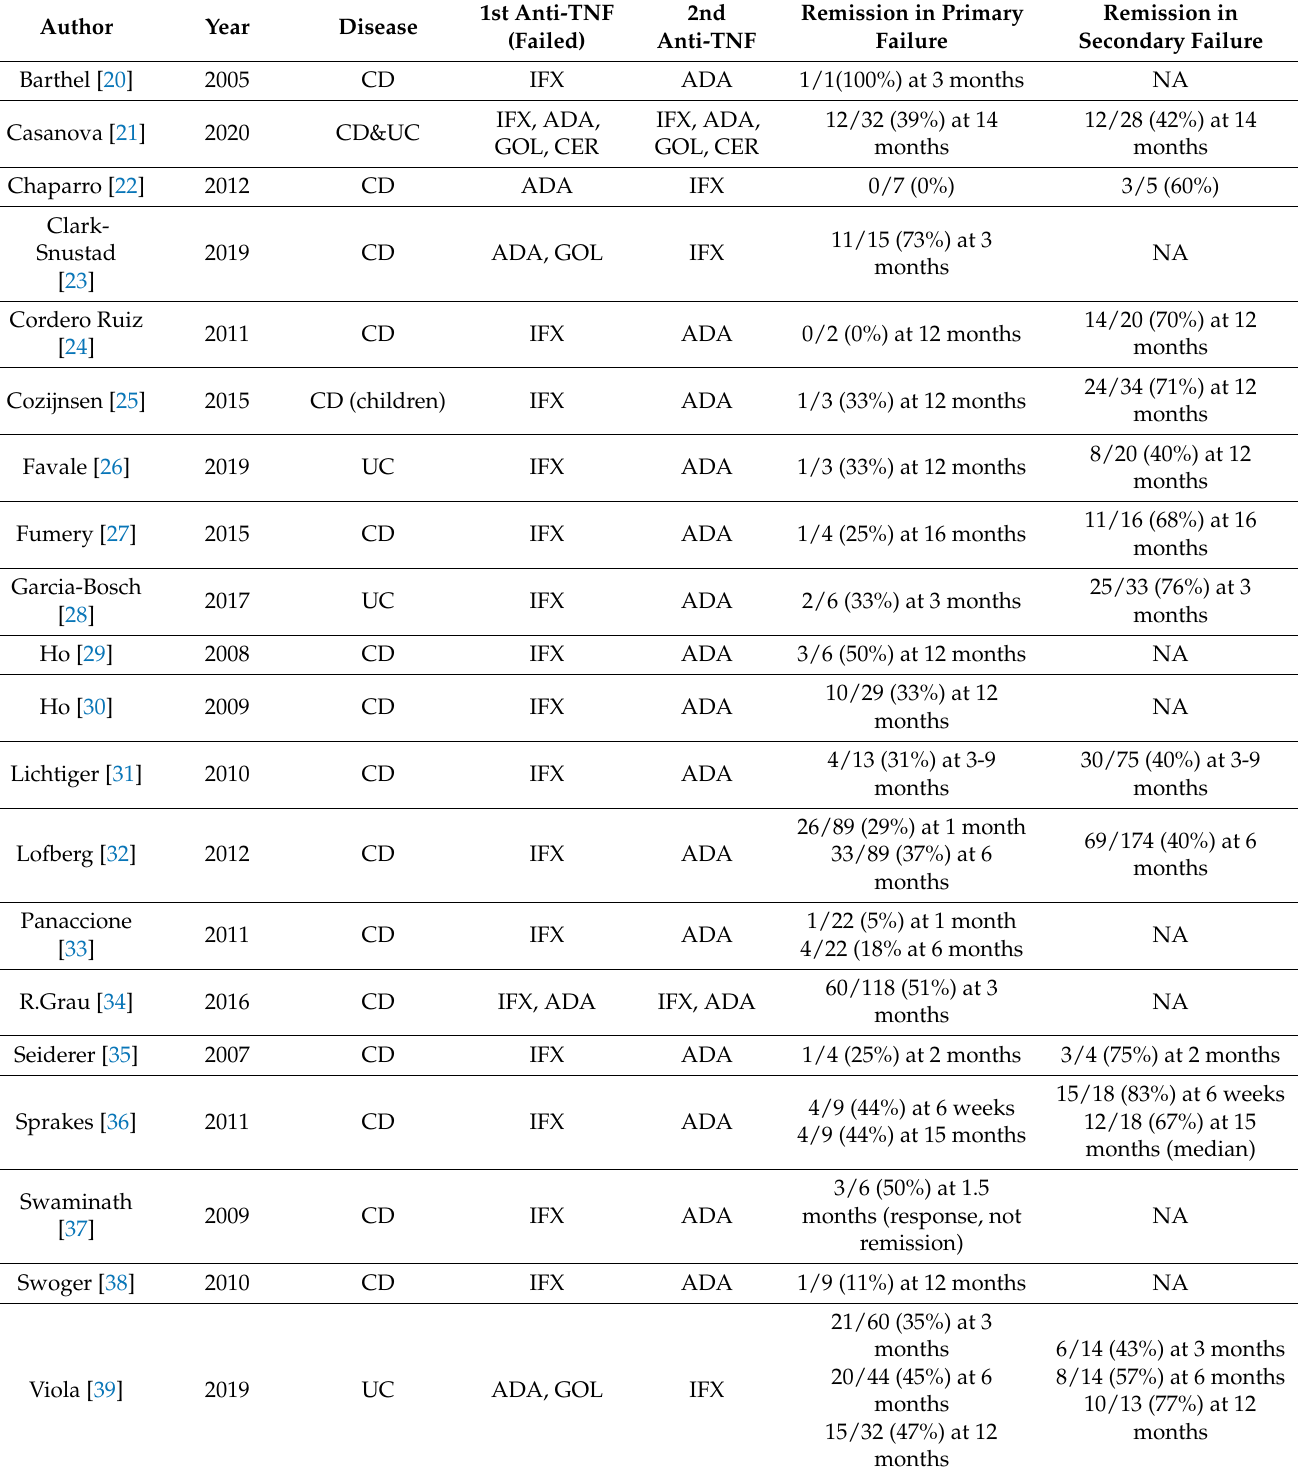
Table 1. Studies evaluating the efficacy of a second anti-TNF agent after primary failure with a first one. Efficacy after secondary failure in those studies, if available, is also